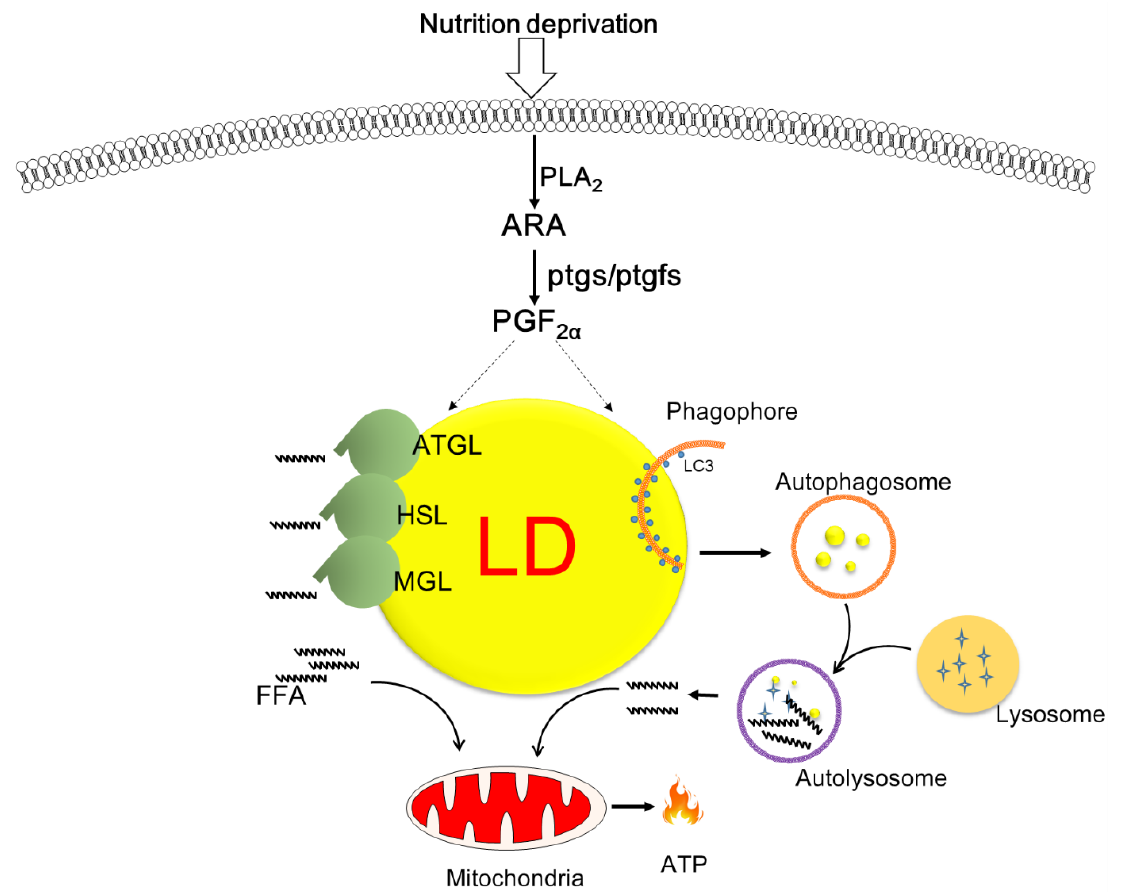
Figure 6. Schematic overview of the proposed role of cyclooxygenase-mediated lipid droplet degra- dation in response to nutrition deprivation in zebrafish hepatocytes. Serum starvation triggers the release of arachidonic acid and augments the production of PGF2 α , which is a key molecule promoting lipid mobilization via autophagy/lipophagy and lipolysis as well as mitochondrial energy